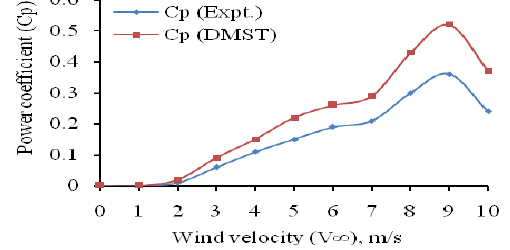
Figure 13. Cp versus V ∞ for variable pitch turbine